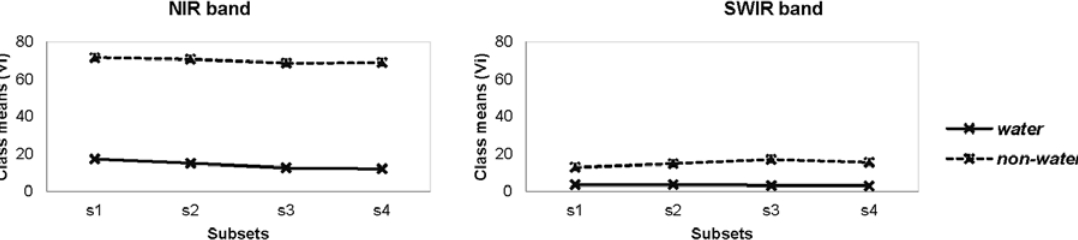
Figure 9. The comparison of the resulting class means of subsets s 1 up to s 4 for image I 10 . The mean values of water class are slightly decreasing when we upscaled the method to larger areas both in NIR (near infrared) and SWIR (shortwave infrared) bands. Whereas, mean values of non-water class are decreasing in NIR band and increasing in SWIR band for subsets s 1 up to s 3 . Table 3. The overall accuracy indicating the water membership agreement between the reference subset s 1 and the target subsets (s 2 up to s 4 ) estimated using fuzzy error matrix for images I 1 , I 6 and I 10 .